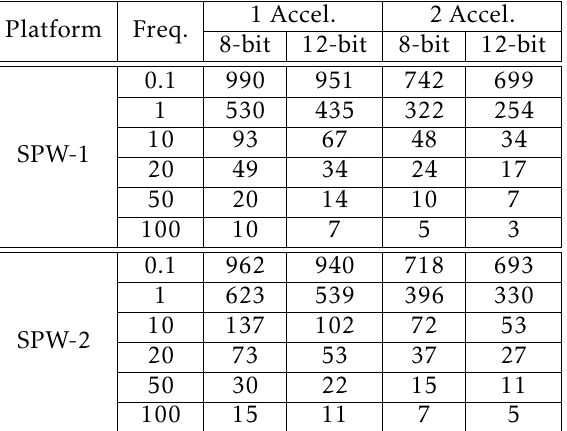
Table 2. Battery Lifetime Approximations in Days Platform